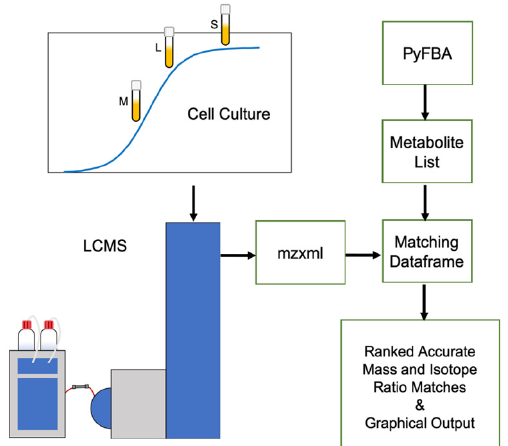
Figure 1. MS_FBA workflow illustrating the necessary input files and algorithmic processes involved in integrating metabolomics data with genome-based metabolic models. The algorithm requires two sets of data: one from mid (M), late (L) and stationary (S) phase cell culture extracts that have been analyzed using untargeted liquid chromatography mass spectrometry (LCMS) that have been